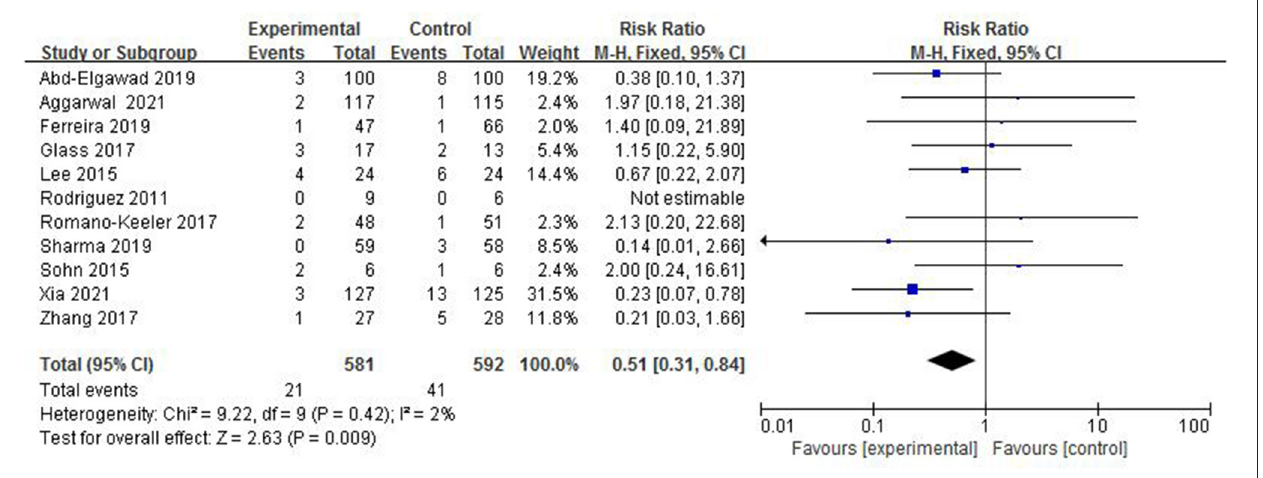
FIGURE 4 | Forest plot of the incidence of